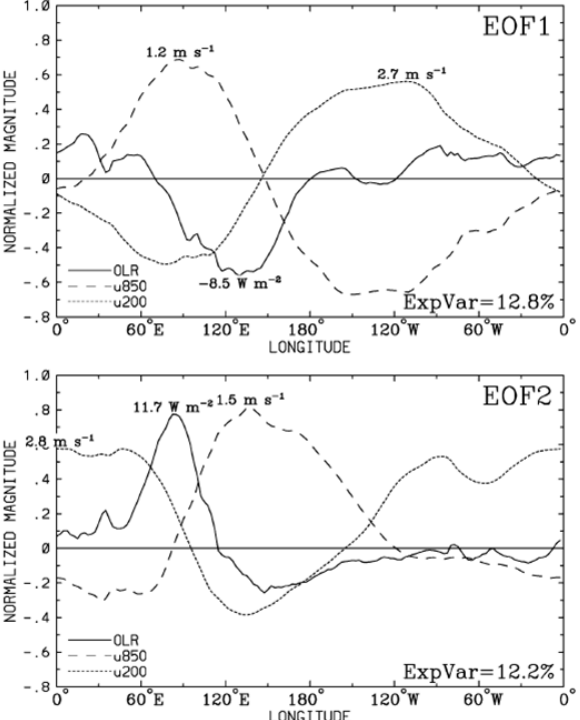
Fig. 4. Figure 1 from Wheeler and Hendon (2004). Spatial struc- tures of EOFs 1 and 2 of the combined analysis of anomalies of OLR, and of zonal wind ( u ) at 850, and 200hPa. The variance ex- plained by the respective EOFs is 12.8% and